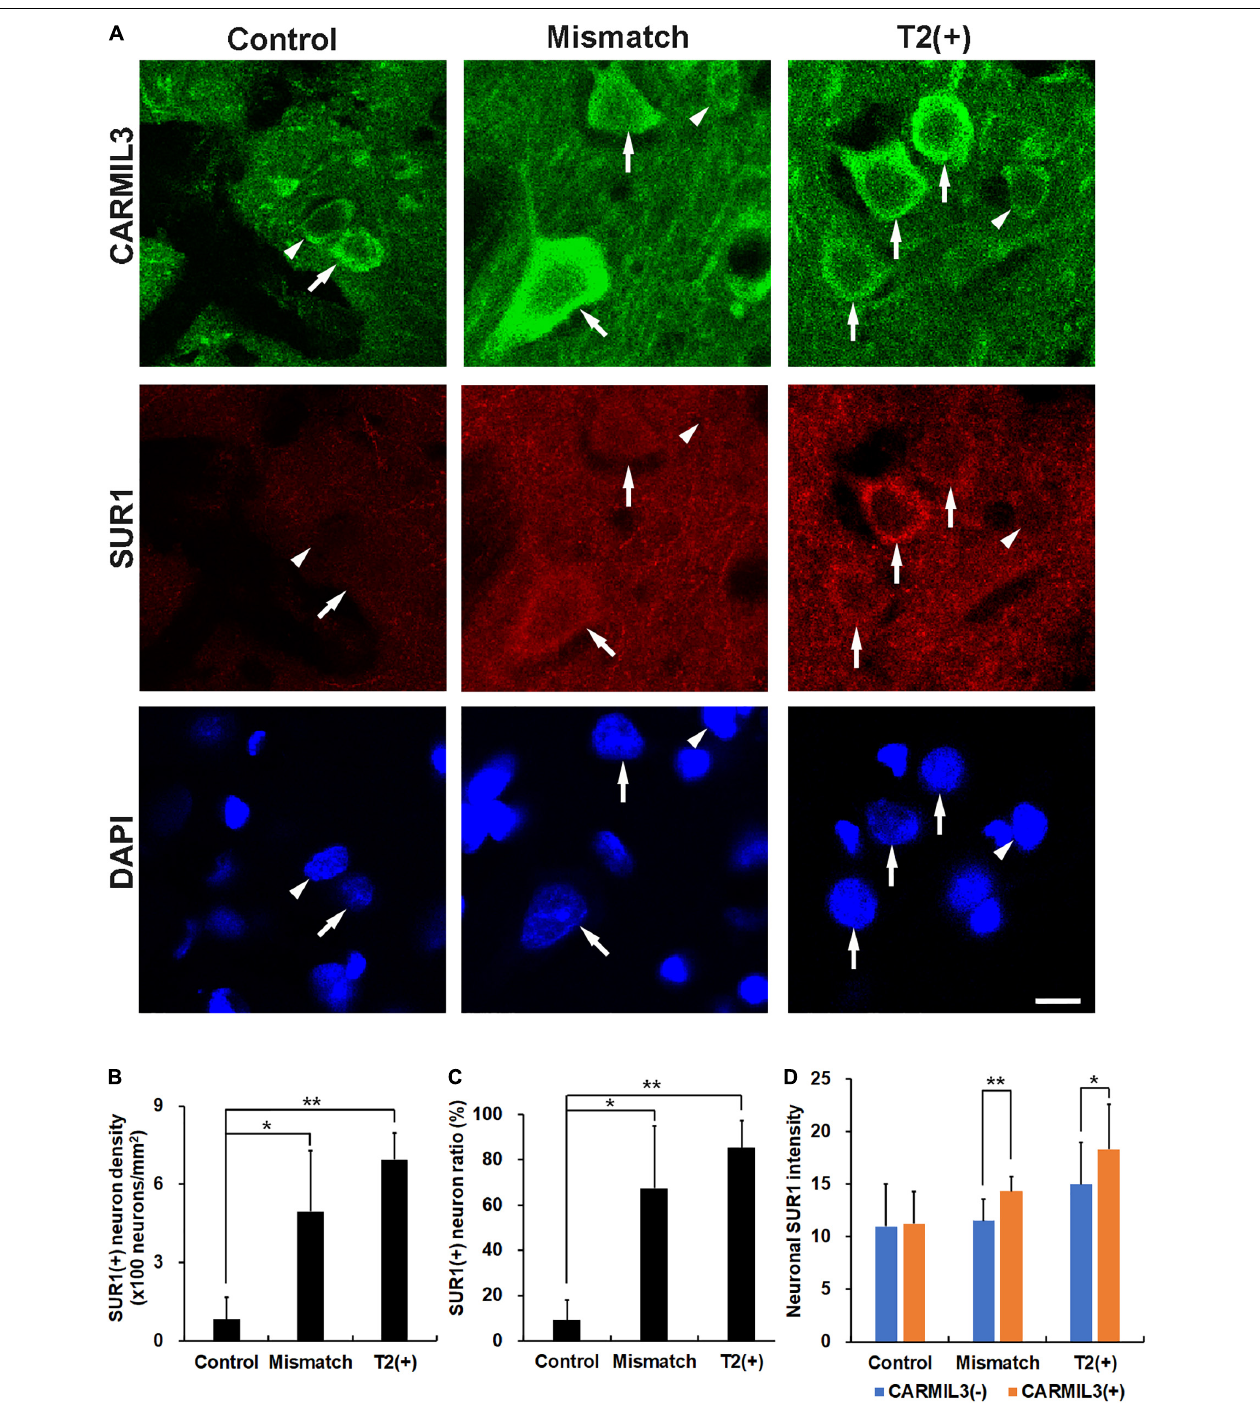
FIGURE 6 | Expression of sulfonylurea receptor 1 (SUR1) in CARMIL3(+) neurons. (A) CARMIL3(+) neurons (arrows) had higher SUR1 intensity than CARMIL3( − ) ones (arrowheads) in the mismatch and T2(+) regions after pMCAO. On the contrary, there was a low expression of SUR1 in the neurons at the control regions. (B,C) SUR1(+) neuron densities were significantly different among the three regions ( p = 0.009), and so were SUR1(+) neuron ratios [the number of SUR1(+) neurons divided by that of all neurons] ( p = 0.015). Higher SUR1(+) neuron densities (B) and neuron ratios (C) were noted in the mismatch and T2(+) regions compared with the control areas (all p < 0.05). (D) CARMIL3(+) neurons had significantly higher SUR1 intensity than CARMIL3( − ) neurons in the mismatch and T2(+) regions. * p < 0.05; ** p < 0.01. N = 4 rats in each group. Scale bar = 10 µ m.